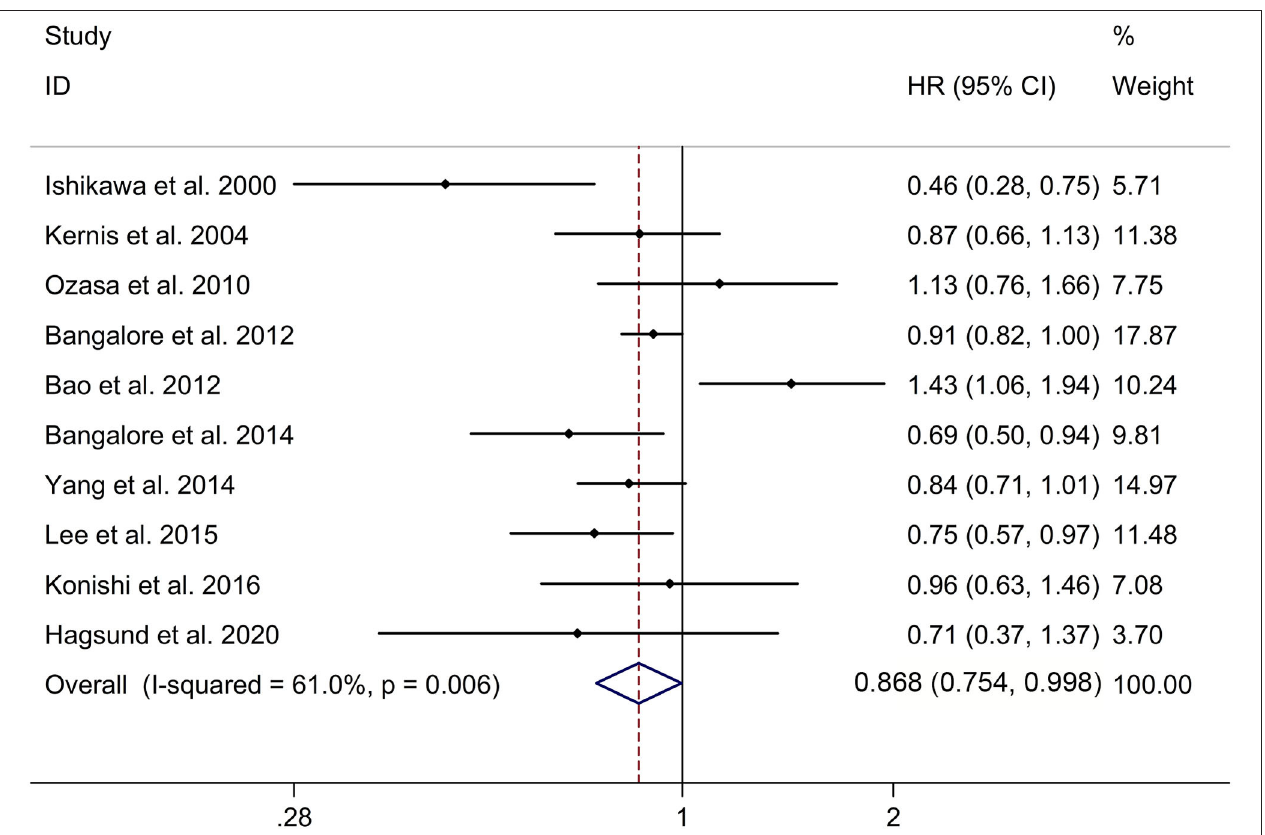
FIGURE 5 | Forest plots exploring the long-term effect of β -blocker use on risk of MACE in patients after MI. CIs, confidence intervals; HRs, hazard ratios; MACE, major adverse cardiac events; MI, myocardial infarction.